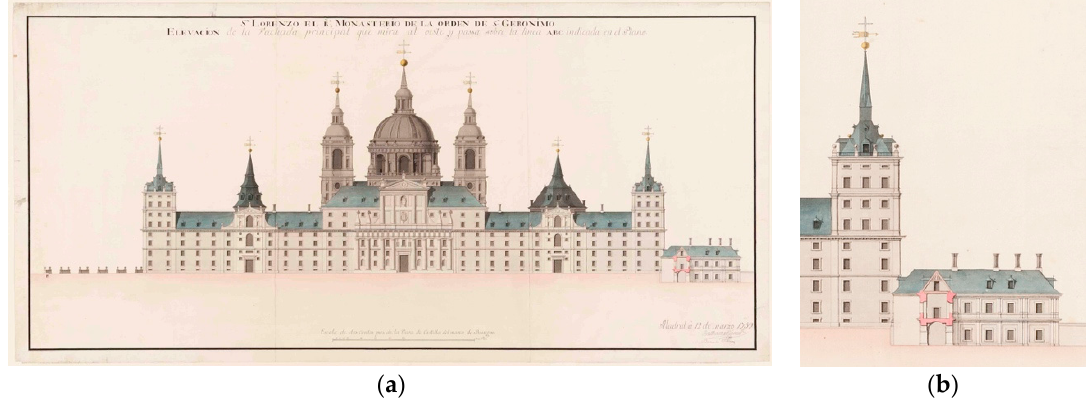
Figure 12. Bernardo Fillera and Balthazar Bécaud, 1759: San Lorenzo el R l Monasterio de la orden de S n Geronimo. Elevacion de la Fachada principal que mira al oeste y passa sobre al linea ABC indicada en el Plano. ( a ) West elevation or main façade. ( b ) Detail of the western elevation of the Botica with a cross section of the arcade that connects with the Compaña. Canadian Centre for Architecture, Montréal, DR1986:0722.